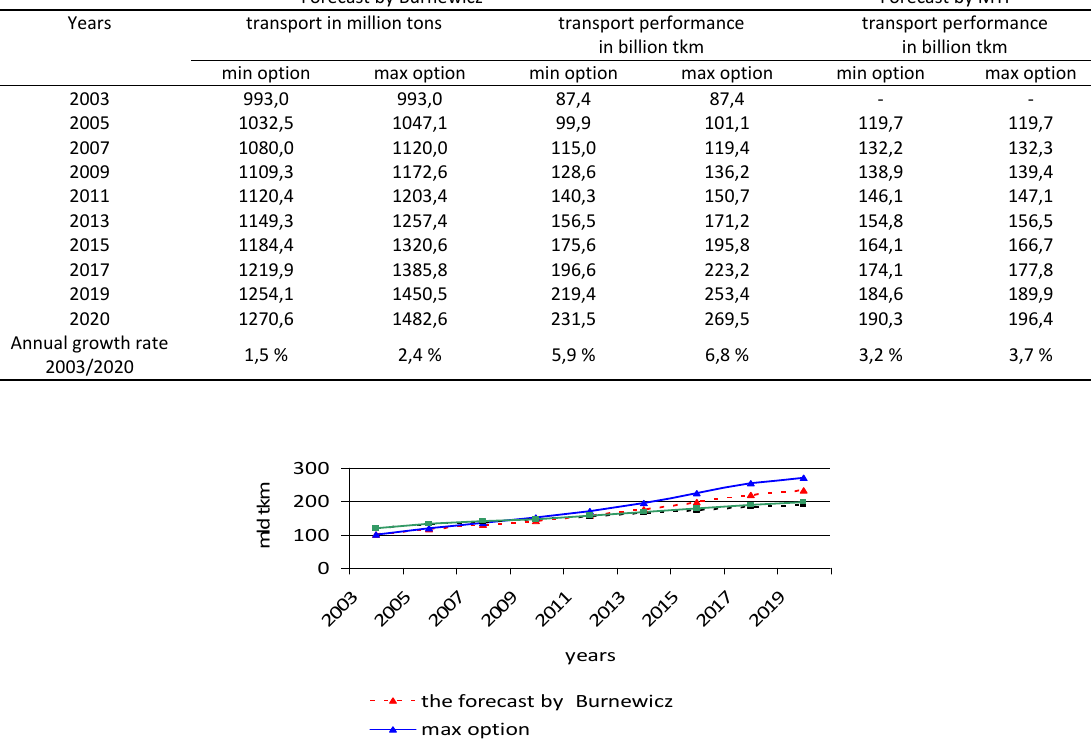
Table 2: The forecasts for the demand for freight transport by 2020 by Burnewicz and Motor Transport Institute (*Burnewicz, 2005; **MTI, 2018) Forecast by Burnewicz*